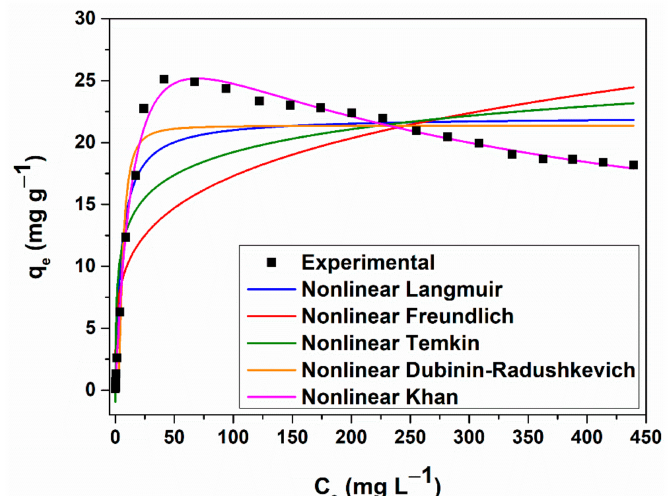
Figure 8. Nonlinear forms of the equilibrium isotherms obtained for CV sorption onto MNP@PAAA- FA Considering both the lowest standard deviation value and the highest coefficient of determination, it can be stated that Khan isotherm model fits the best CV adsorption process. Thus, the α K value (1.38) is around 1, indicates that the CV adsorption process approaches the Langmuir isotherm at lower concentrations, while at higher values, this model reduces to the Freundlich